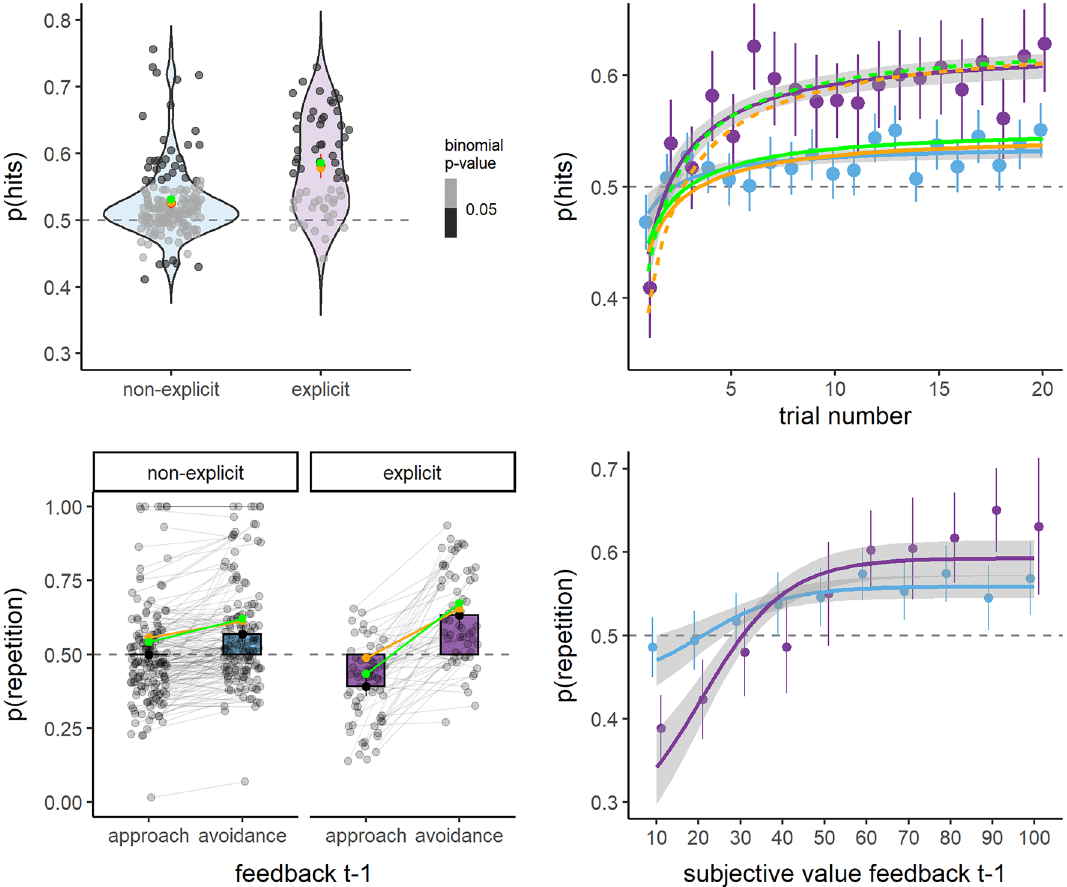
Figure 3. Summary of behavioral results as a function of the presence/absence of an explicit avoidance strategy. All information provided in the legend for Fig. 2 applies to Fig. 3. The figure highlights the differences between the group without an explicit avoidance strategy (light blue) and the group with an explicit strategy (violet). Prediction from the simple and the counterfactual reinforcement learning models (see next paragraph and “Methods”) are in orange and green, respectively (solid lines for the group without an explicit strategy and dotted lines for the one with explicit strategy). Orange and green points represent means of simulations, and the fitted curve in the right top graph represents the best fit for the same hyperbolic function used in the mixed linear models, fitted on simulated The Friedman test on RL model log-likelihood was statistically significant, χ 2 (2) = 78.8, p < 0.001, indicating a difference in the ability of the models to fit the data (Fig. 4, left top). Wilcoxon paired tests, Bonferroni corrected, further indicated that the random model (median = − 206, min = − 208, max = − 175) had a lower likelihood com- pared to both the simple (Z = 2613, p corr < 0.001, effect size = 0.67; median = − 198, min = -210, max = − 3.87) and the counterfactual models (Z = 2432, p